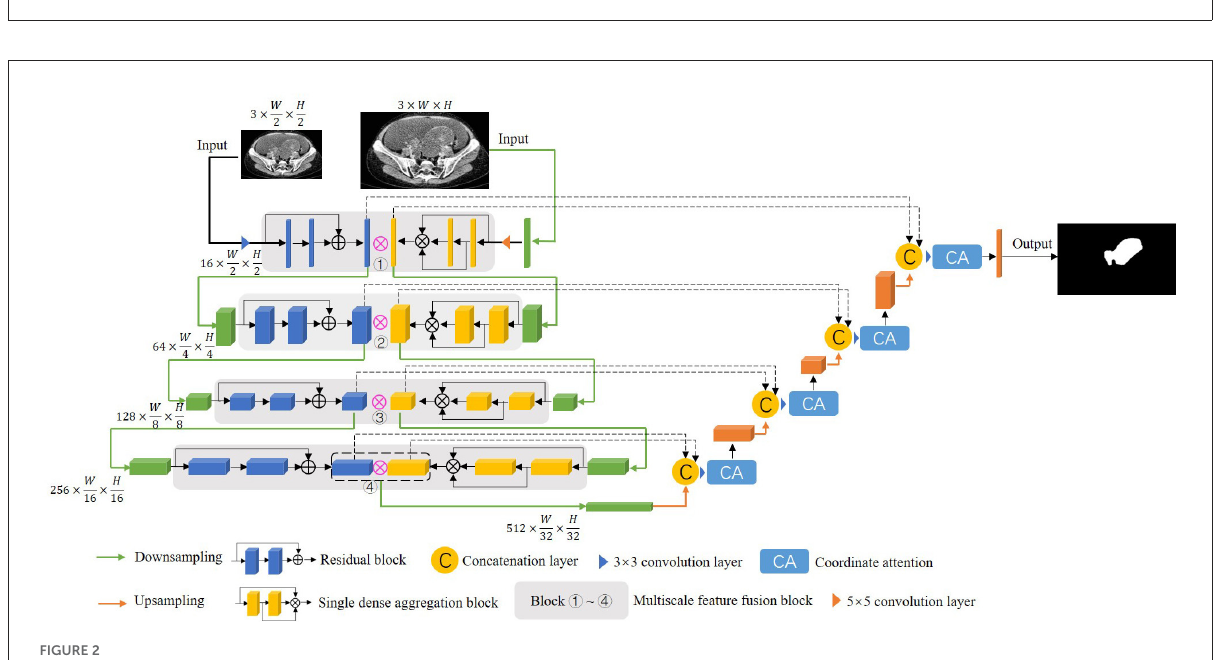
FIGURE2 The structure of the proposed DMFF-Net in this